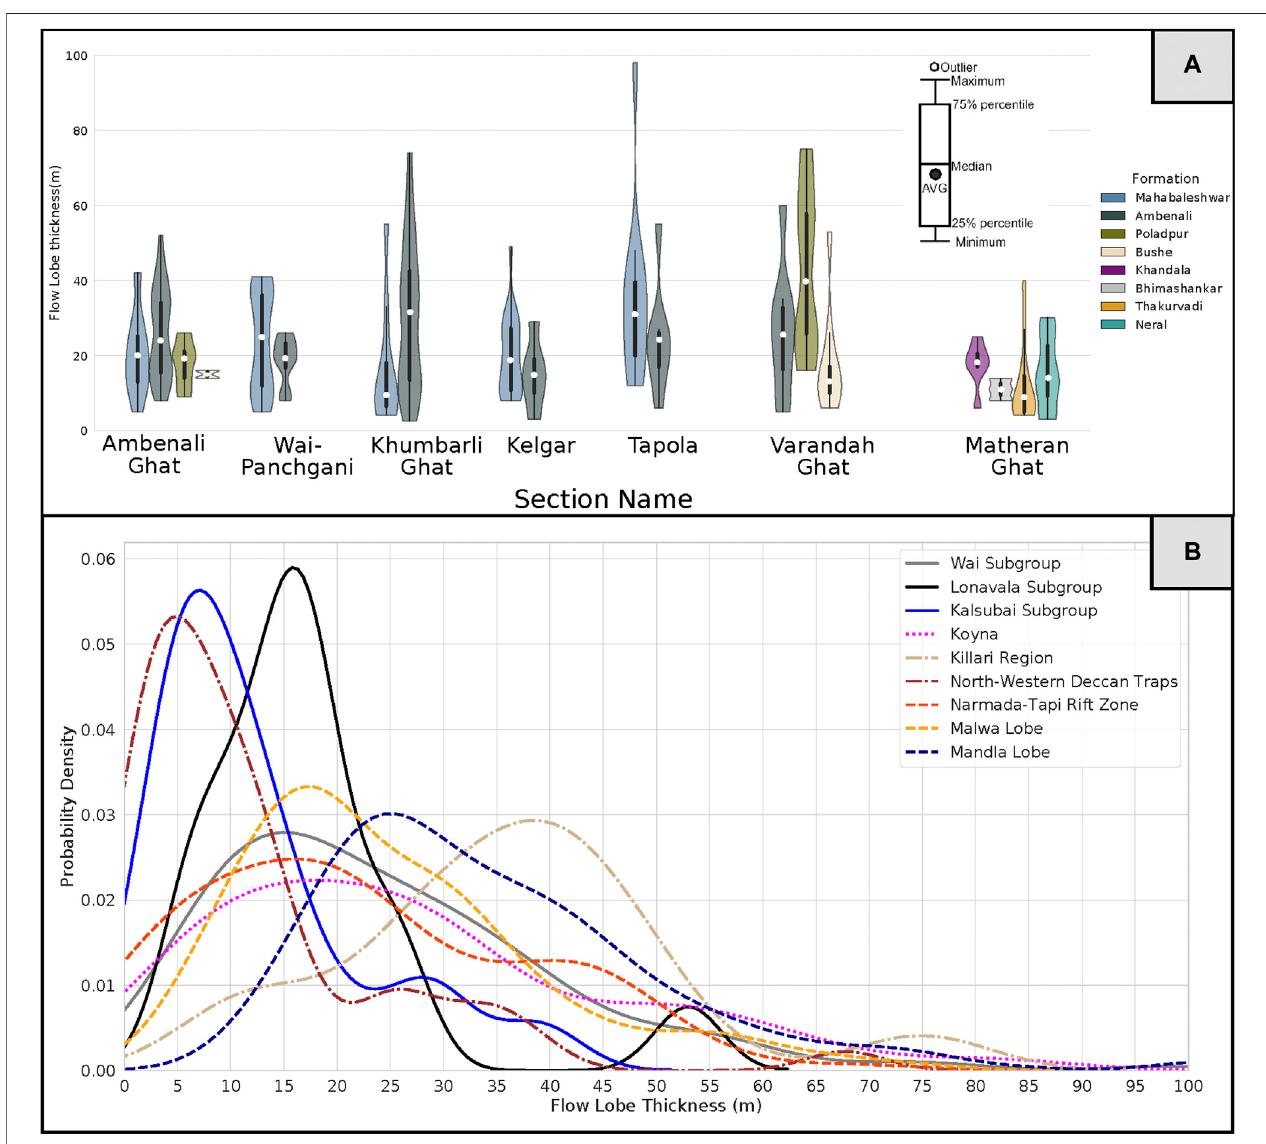
FIGURE 6 | (A) Violin plot of fl ow lobe thickness variation ( y axis) vs formations in various traverses through DVP lavas of Western Ghats ( x axis). Width of violin represents amount of data for each formation and thickness range encapsulated in vertical distribution. White dot marks mean of distribution and black bar 75th – 25th percentile range. (B) Same as Figure 5B , but with PDF for two Koyna area cores added (Koyna); note similarity with upper (Wai) sub-group PDF. In addition, fl ow lobe thickness datasets shown for Killari region (South-Eastern Deccan Plateau, Wai subgroup fl ows), and Deccan sub-Provinces (Mandla, Malwa, Narmada-Tapi Rift Zone (cid:1) Satpura, and North Western Deccan (cid:1) Cambay Rift Zone/Saurashtra, see Figure 1A ).